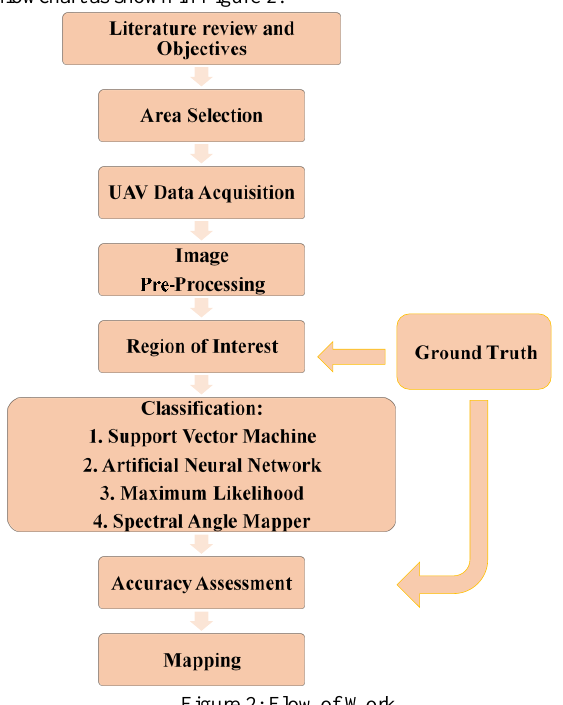
Figure 2: Flow of Work